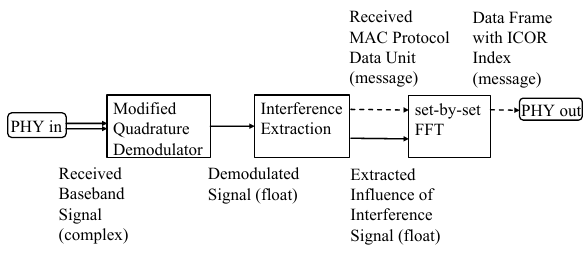
Figure 12. Extended physical layer implemented in GNU